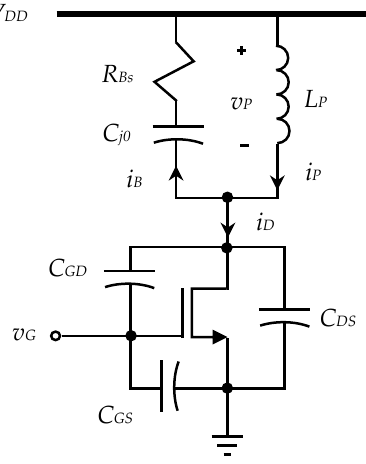
Figure 5. Equivalent circuit for the drain-source voltage rising phase. The current flowing in the snubber is written as